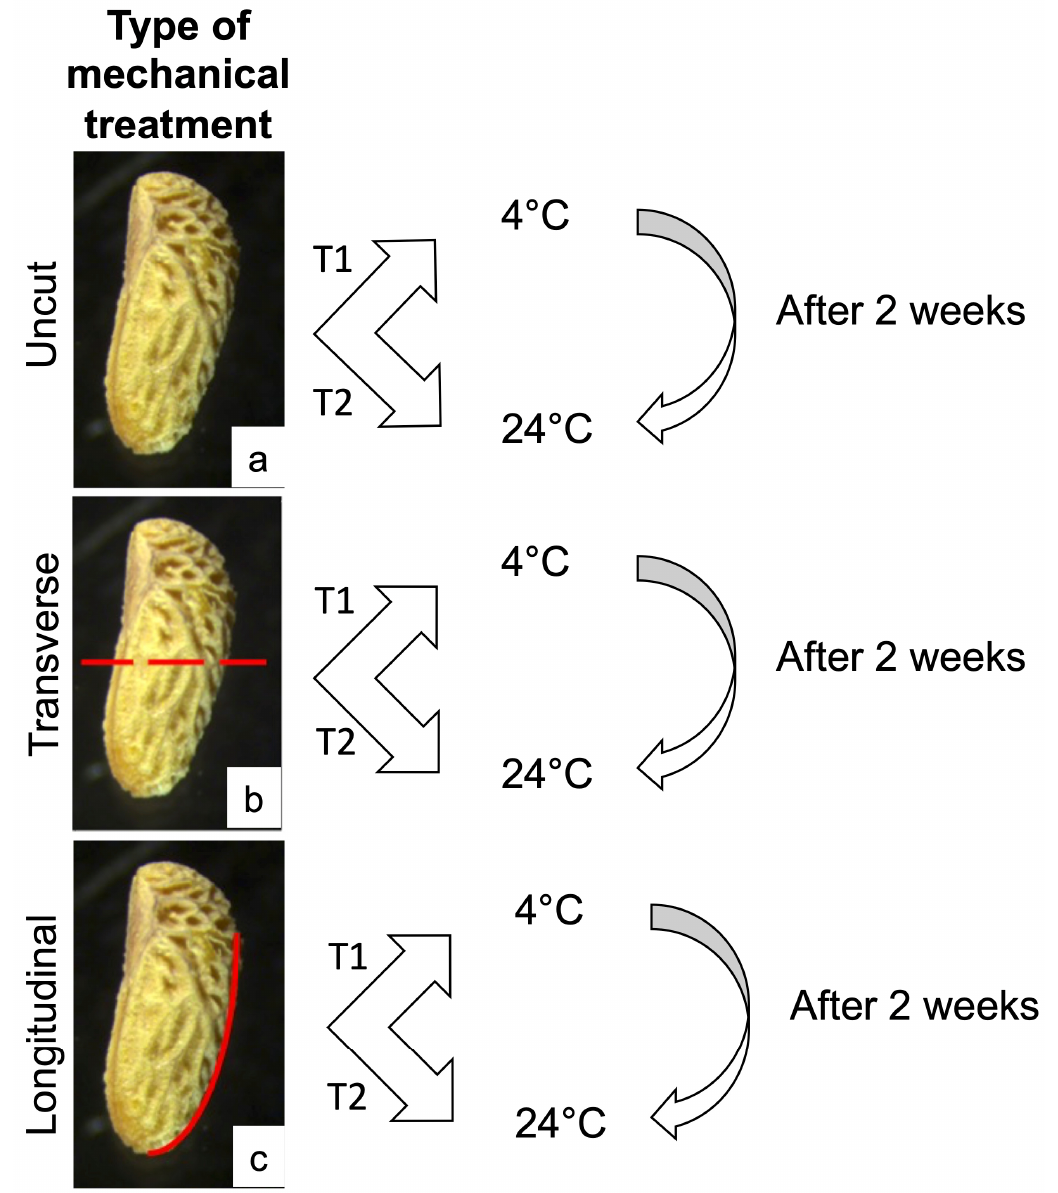
Figure 1. Type of mechanical and temperature treatments applied on seeds before in vitro culture: ( a ) uncut seed, ( b ) transverse cutting (halved seed), ( c ) longitudinal incision, stored at 4 °C for 14 days and then in vitro cultured at 24 °C (aT1, bT1, cT1), or placed directly in a growth chamber at 24 °C (aT2, bT2, cT2).